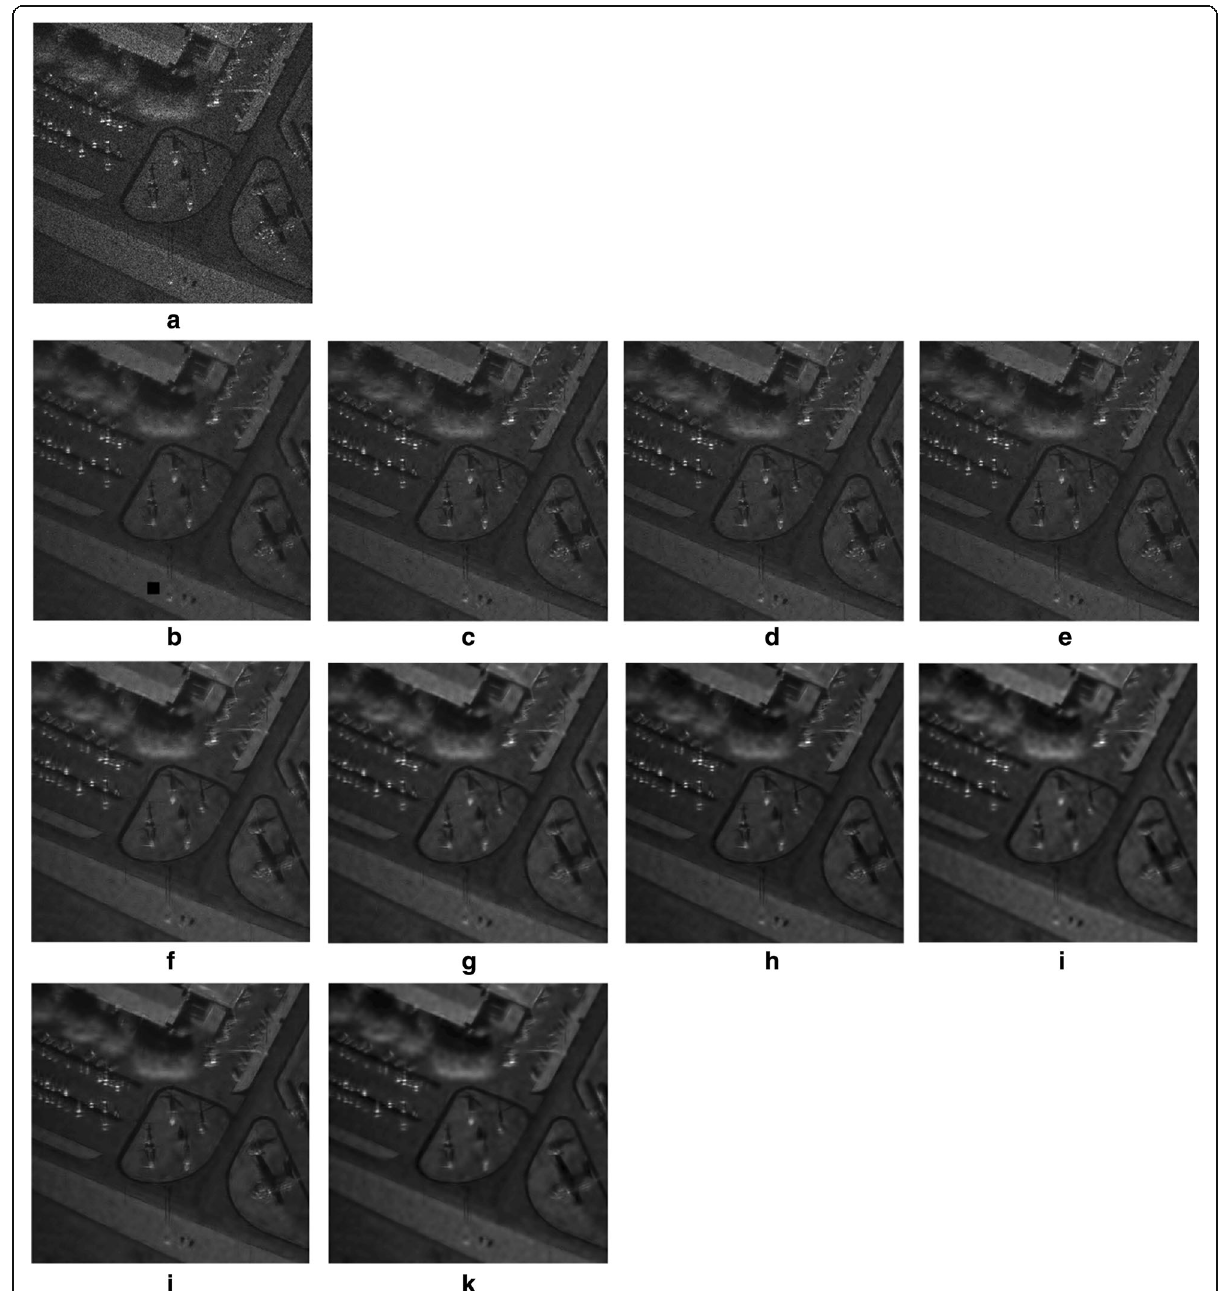
Fig. 9 a original SAR image Air Craft with size 512 × 512, b – e despeckled images by B-SWT [30], WB-SWT, BI-SWT, WBI-SWT, and f – k despeckled images by B-NSST [2], WB-NSST [27], BI-NSST(1), WBI-NSST(1), BI-NSST(2), and